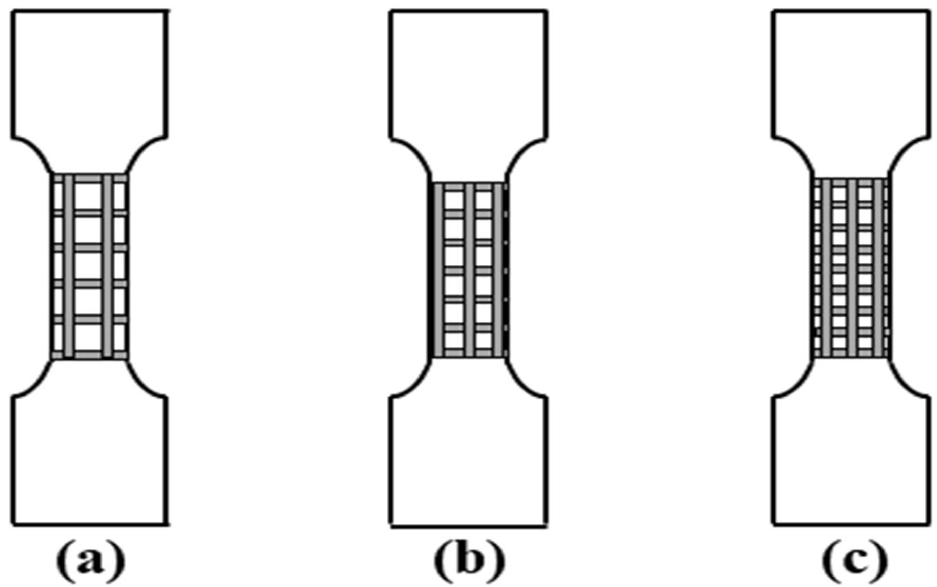
Figure 5. Processing diagram of biomimetic tensile samples with different spacings: ( a ) 3.5 mm; ( b ) 2.5 mm; ( c ) 1.5 mm.